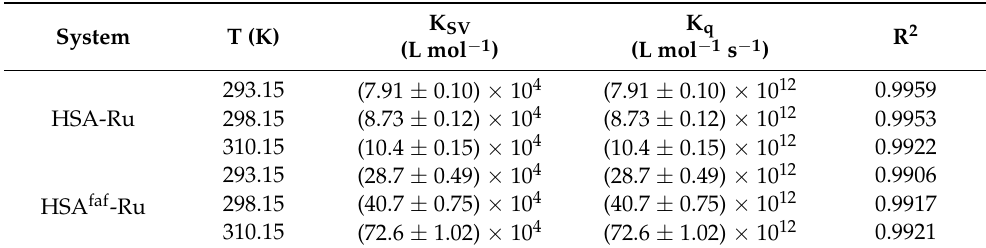
Table 5. Stern–Volmer quenching constants for HSA-Ru and HSA faf -Ru systems at different tempera- tures. Data are represented as mean ± SD of n = 3 independent experiments.